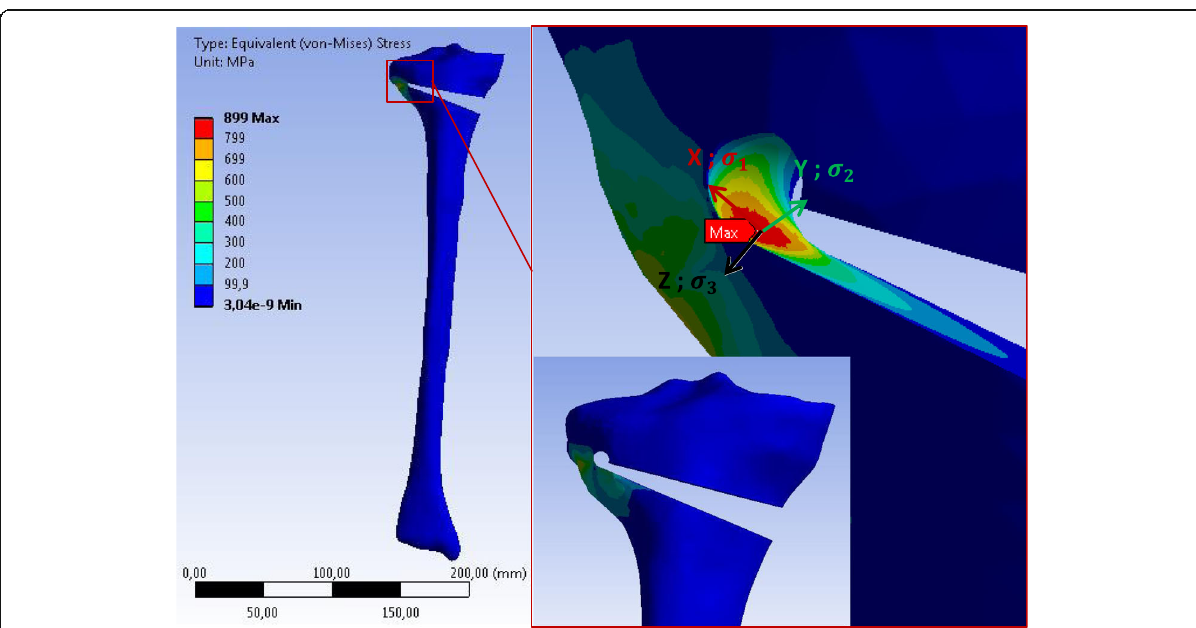
Fig. 12 Equivalent (von-Mises) stress in the specimen SWHA obtained with 3D linear FEA: Only the result for case study H is represented. The stress values correspond to an opening angle of 10°. The specimen has been slightly rotated in the zoom-view on the right to show the location of the reference point where the equivalent (von-Mises) stress was maximum